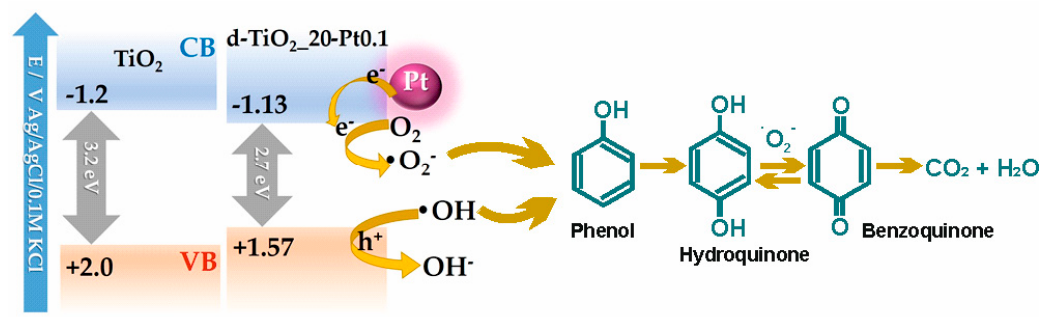
Figure 12. Energy diagram depicting the position of valence and conduction bands of bare and modified titania including the indication of charge transfer within the Schottky junction, and schematic illustration of phenol degradation mechanism over defective Fe 3 O 4 @SiO 2 /d-TiO 2 -Pt/Cu photocatalysts.